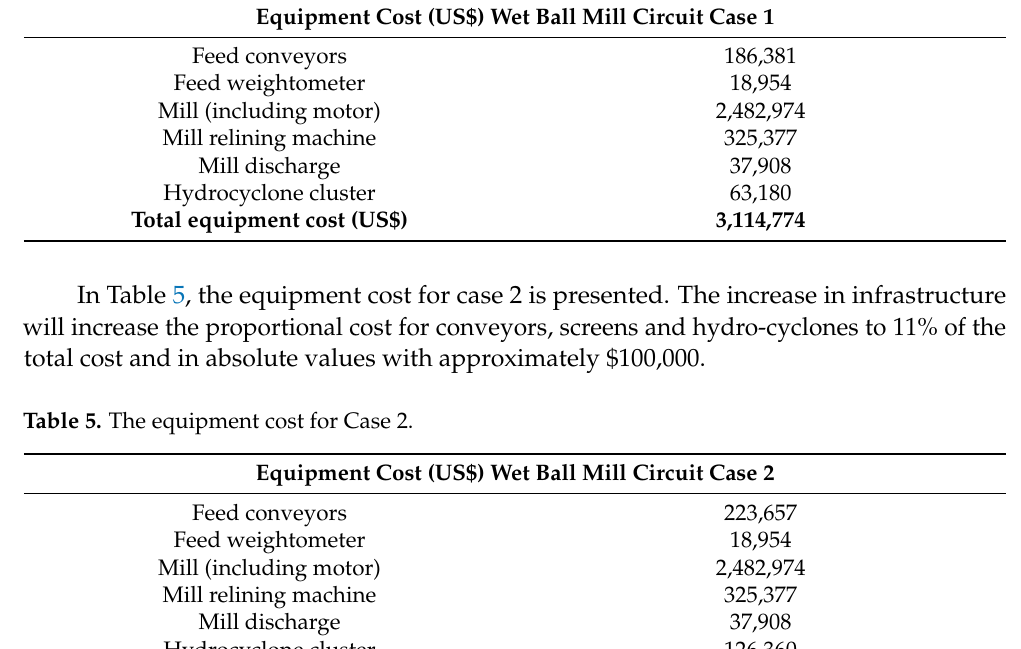
Table 4. The equipment cost for Case 1.